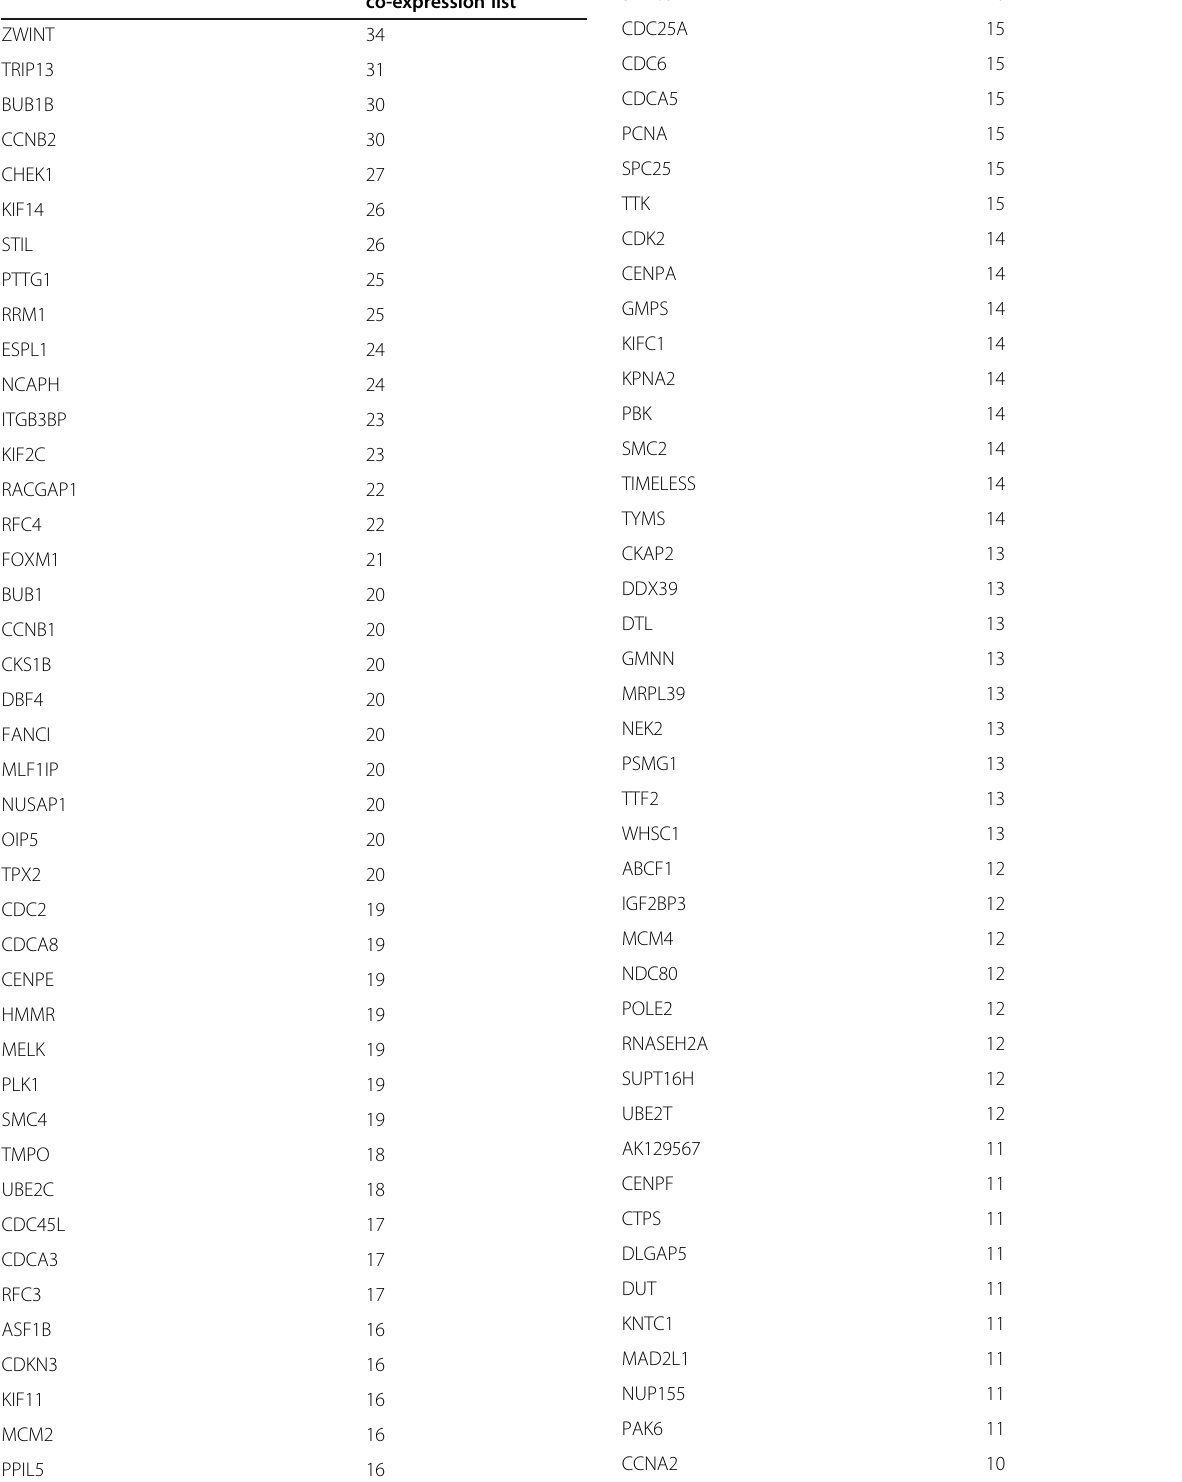
Table 2 Top-ranking genes that co-express with 64 core centromere-kinetochore components